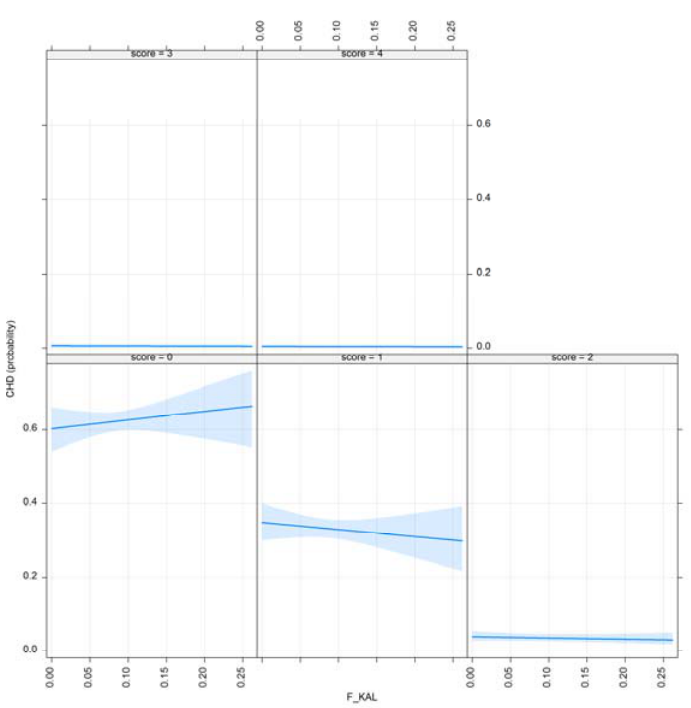
ff ect plot of F Figure 6. Effect plot of F _KAL for CHD. Figure 6. E